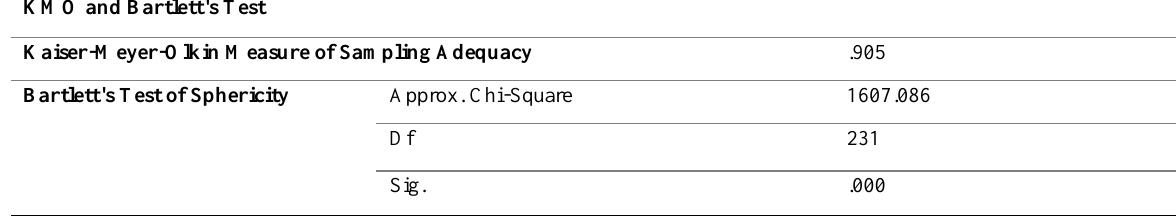
Table 3: Kaiser-Meyer-Olkin (KMO) and Bartlett’s